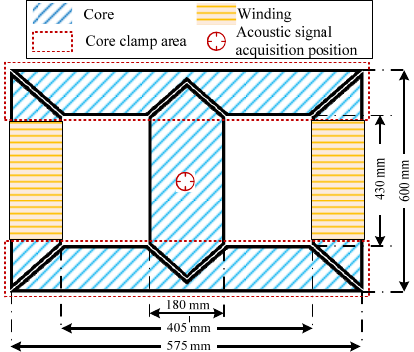
Figure 2. Model size and signal acquisition layout of the core.